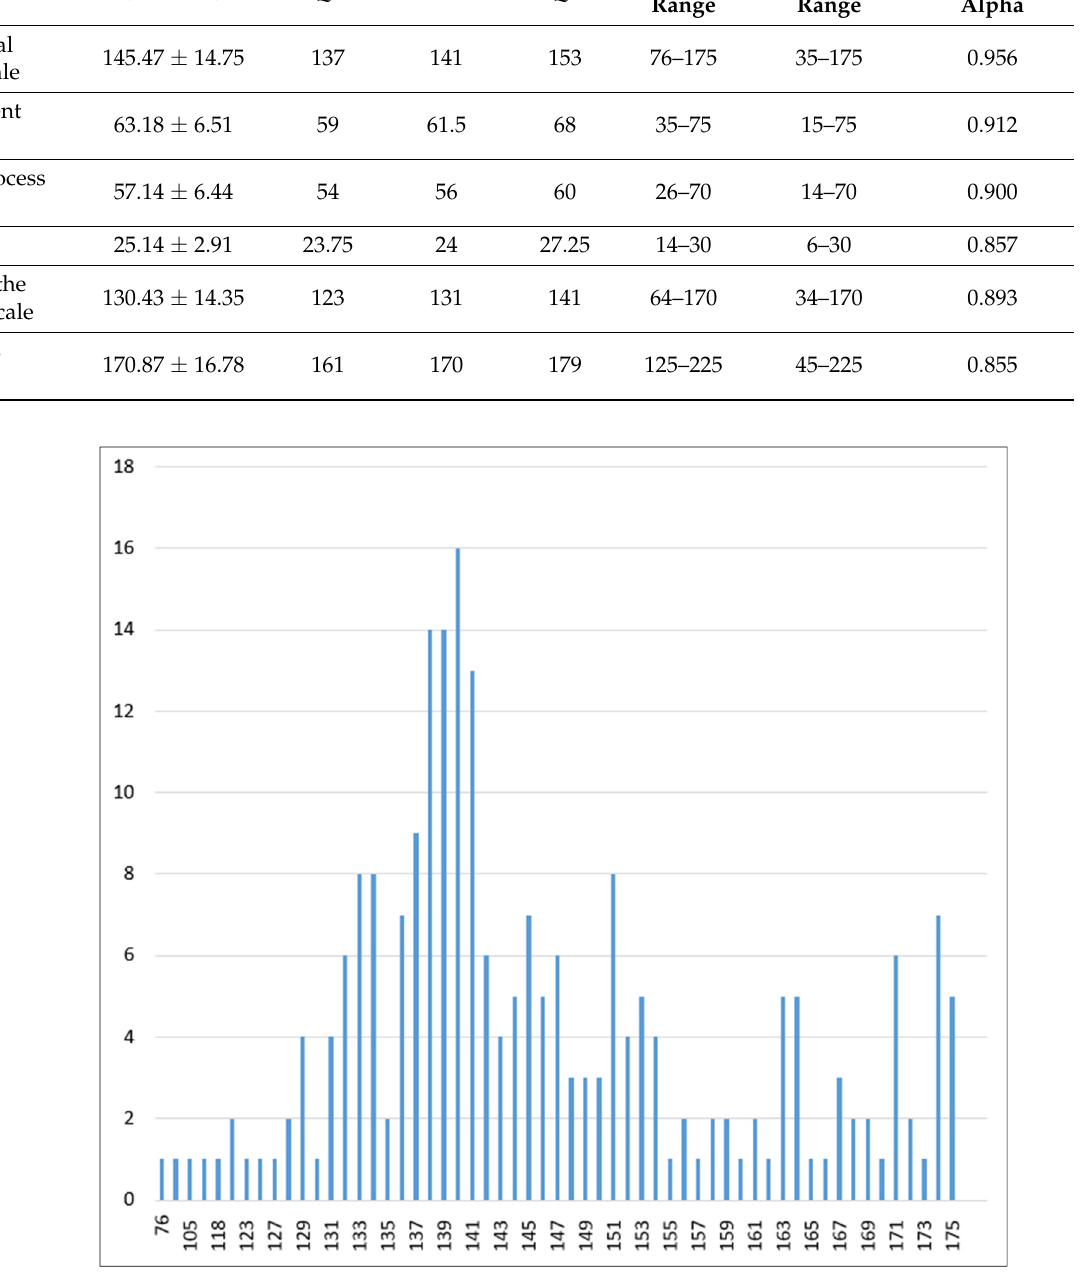
Figure 1. Self-efficacy scores distribution (N = 234).